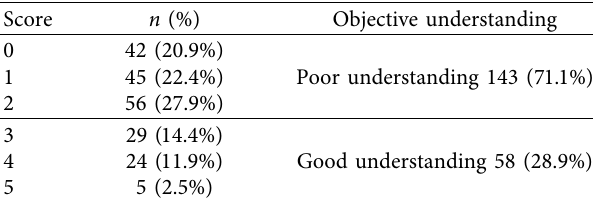
Table 2: Patients’ objective understanding based on the postprocedure